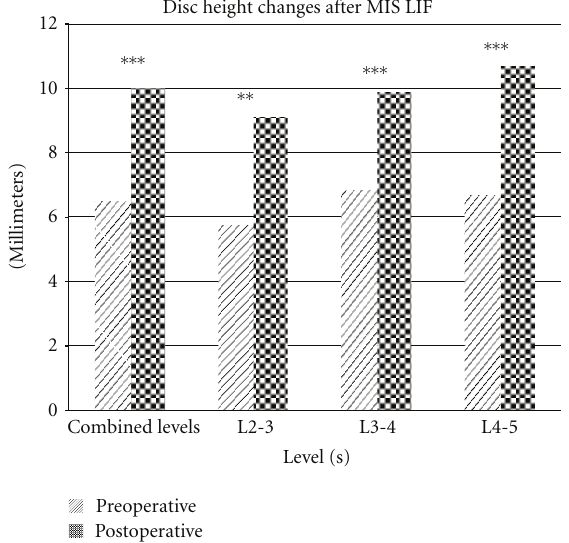
Figure 5: Disc height changes after MIS LIF. Statistically significant increases were observed at each measured level as well as in aggregate. ( ∗ = P < 0 . 05, ∗∗ = P < 0 . 01, ∗∗∗ = P < 0 .